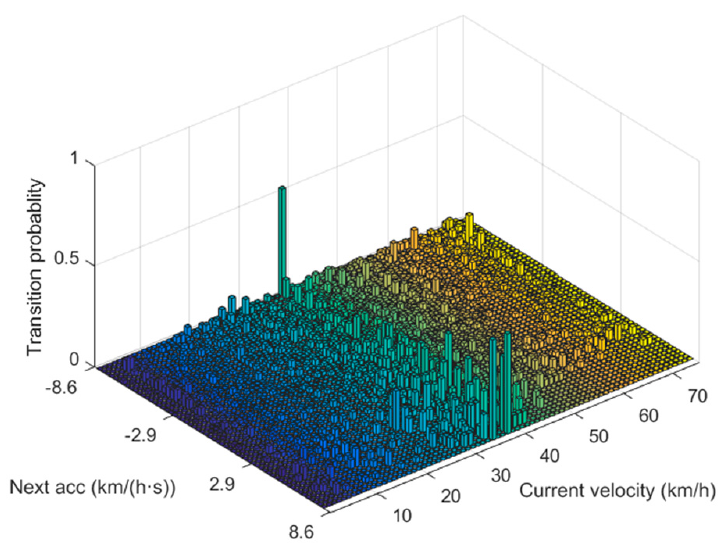
Figure 6. Transition probability map of city conditionz.